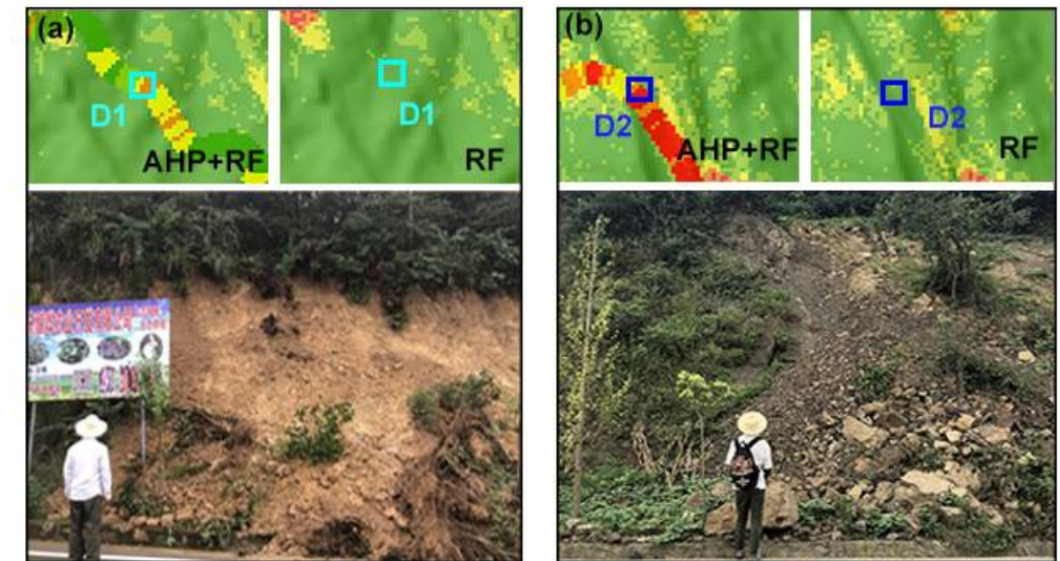
Figure 13. The comparison between the landslide susceptibility map based on only the RF model and the one revised from the AHP model. ( a ) Two susceptibility maps and photo of the D1 landslide. ( b ) Two susceptibility maps and photo of the D2 landslide. (The locations of two new landslides are shown in Figure